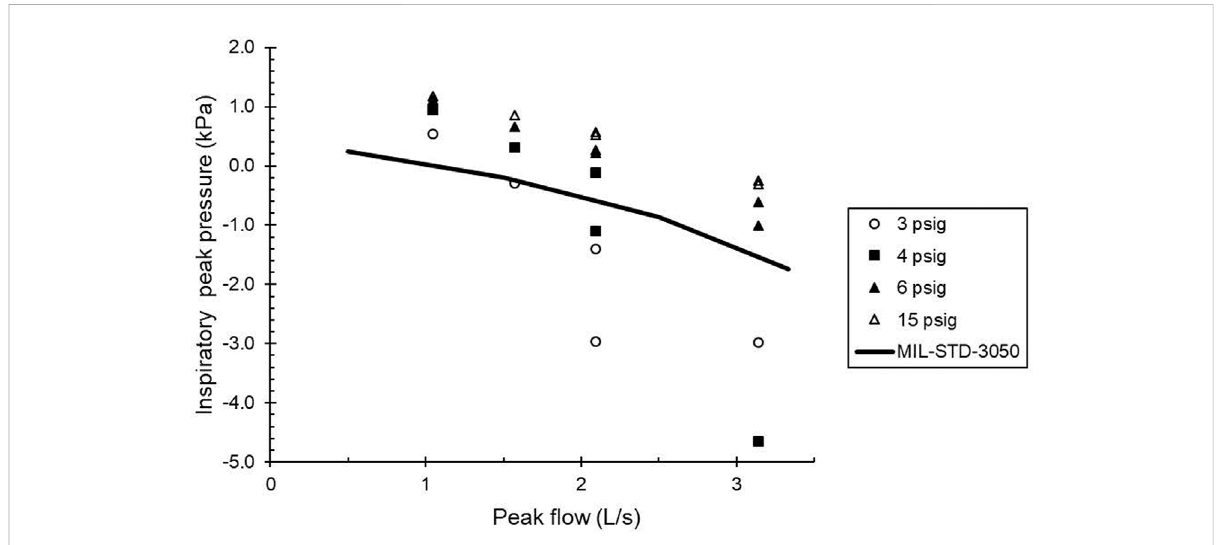
FIGURE 1 Comparison of minimum inspiratory pressures (peak inspiratory pressure) as a function of fl ow to the inspiratory portion of the “ trumpet curve ” ofMILSTD3050.Solidline:standard.Symbols:measuredvalues.Data arelabeledwiththeirnominalsupplypressures.Pointsabovethesolidlineare within the standard. Peak fl owswith two separate pressures plottedweregenerated with different tidal volume — frequency combinations set on the breathing